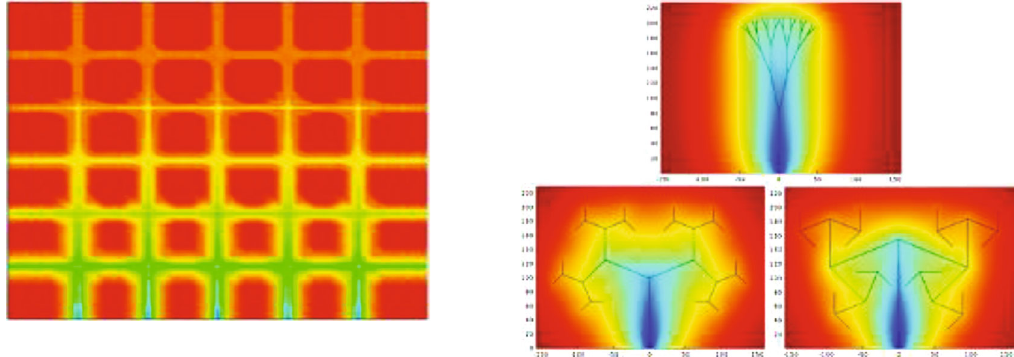
Figure 7: Inversion method of fracturing fracture